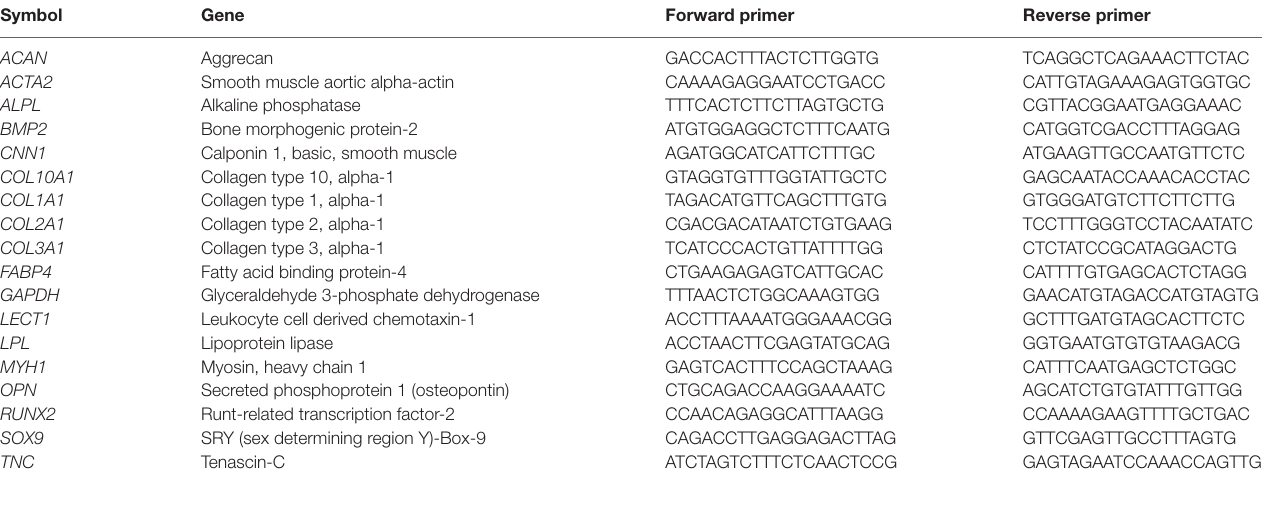
symbol gene Forward